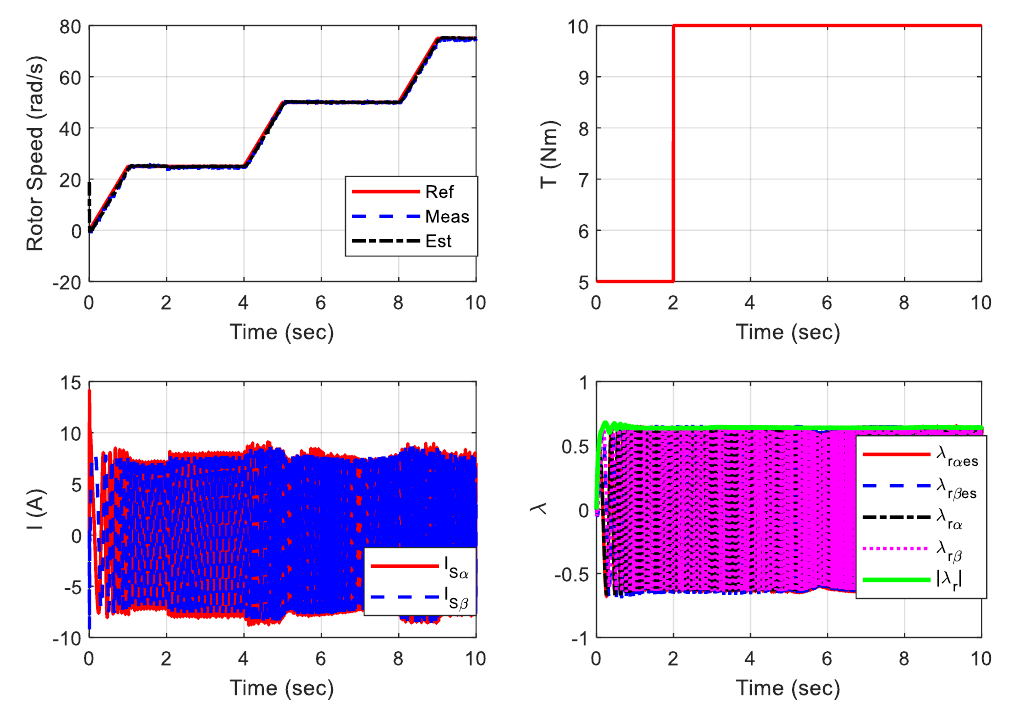
Figure 22. Response of the proposed drive with ANN-based estimators considering the case of rotor speed variation.